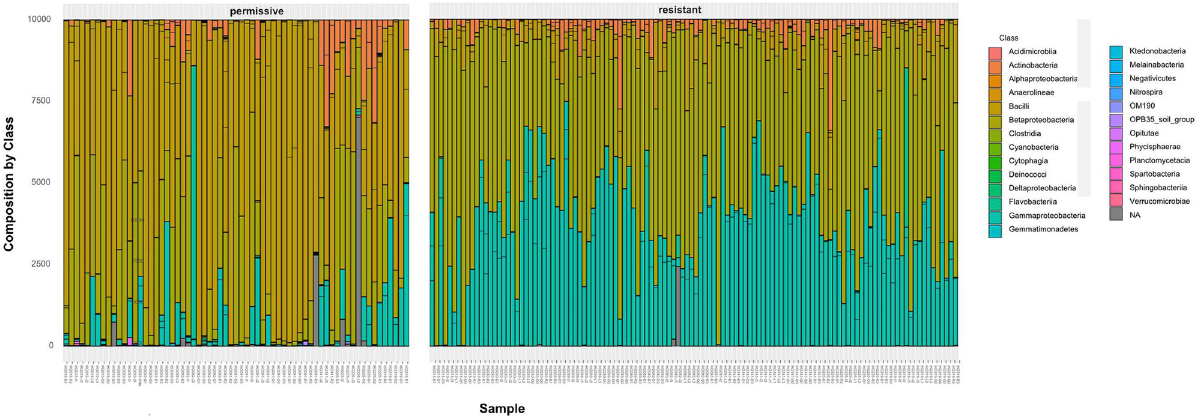
Fig 5. zOTU-composition at the level of systematic class. Shown are the samples in the ’permissive’ (negative; left panel) and the ’resistant’ (positive; right panel) group (see text). Bacilli/Betaproteobacteria and Gammaproteobacteria make a difference (see colour code). Distances for ordination based on weighted unifrac ( wuf